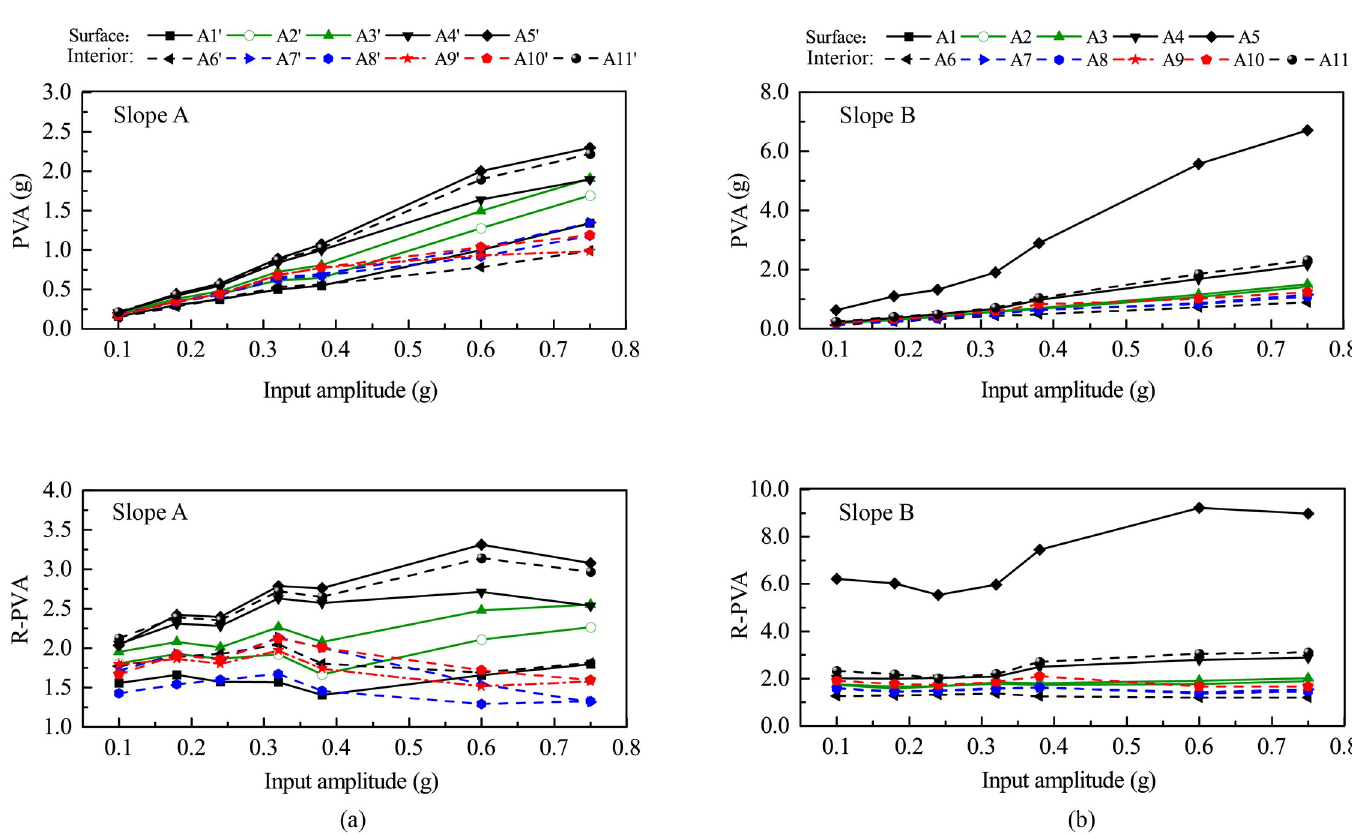
Fig 11. Peak vertical acceleration (PVA) and corresponding amplification factor (R-PVA) of all monitoring points vs. amplitude of vertical input acceleration: (a) Slope A; (b) Slope B.